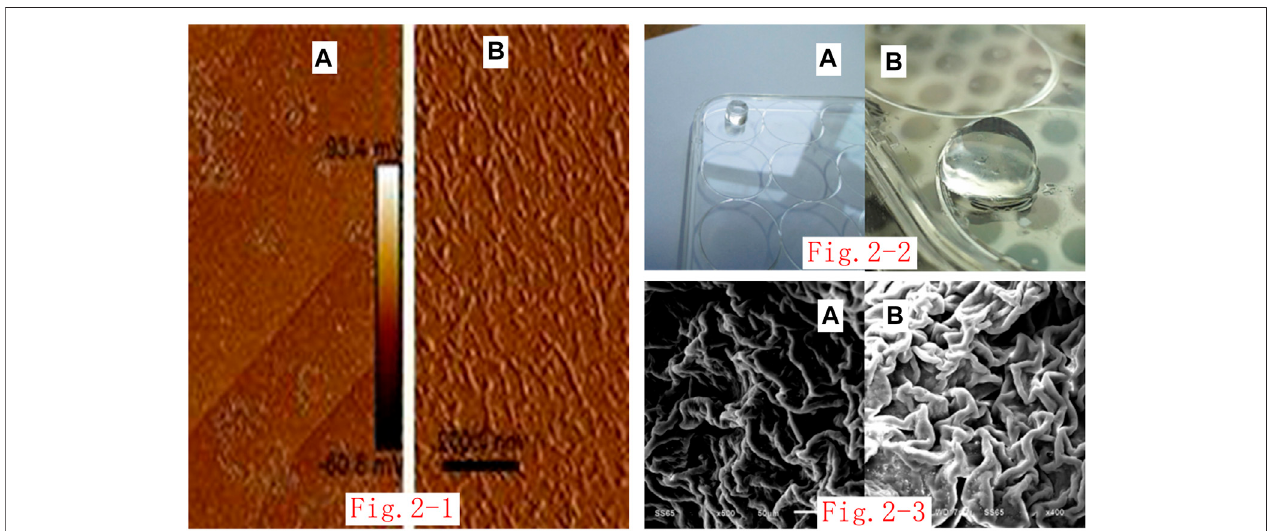
FIGURE 2 | (i) . Atomic-force microscope image of self-assembled nanopeptide solution: (A) : The nano fi ber arrangement can be seen by imaging for the three- peptide mixed solution at 2.0 μ m. (B) : The nano fi ber arrangement can be seen by imaging for the three-peptide mixed solution at 200 nm. (ii) . Image of gelation of